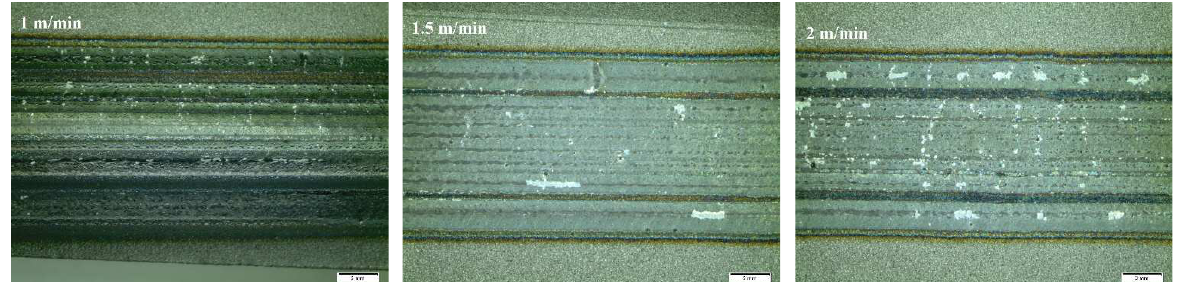
Figure 4. Morphology of the laser-alloyed tracks of surface of SSSs for sample 1.